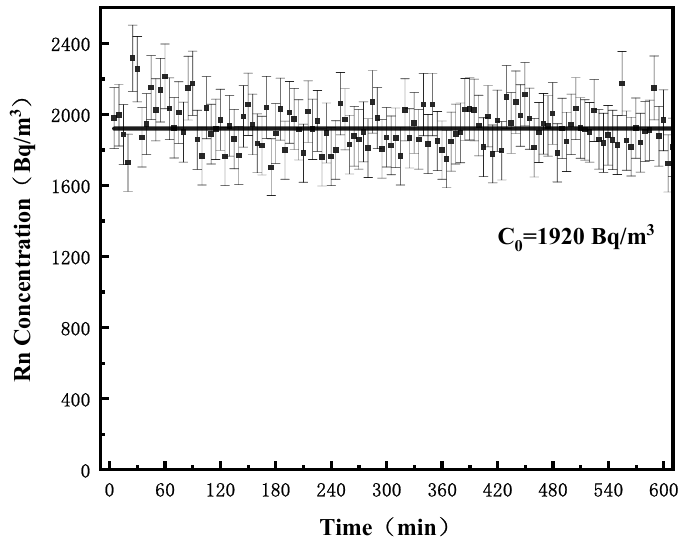
Figure 4. Rn concentration without samples over time.